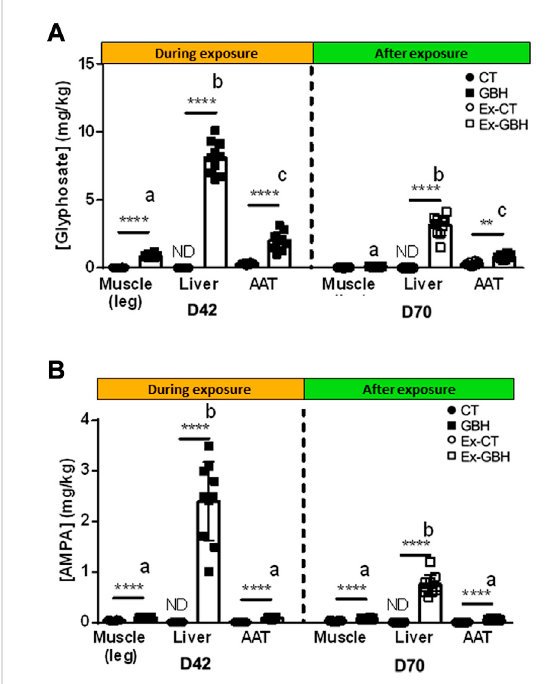
During exposure